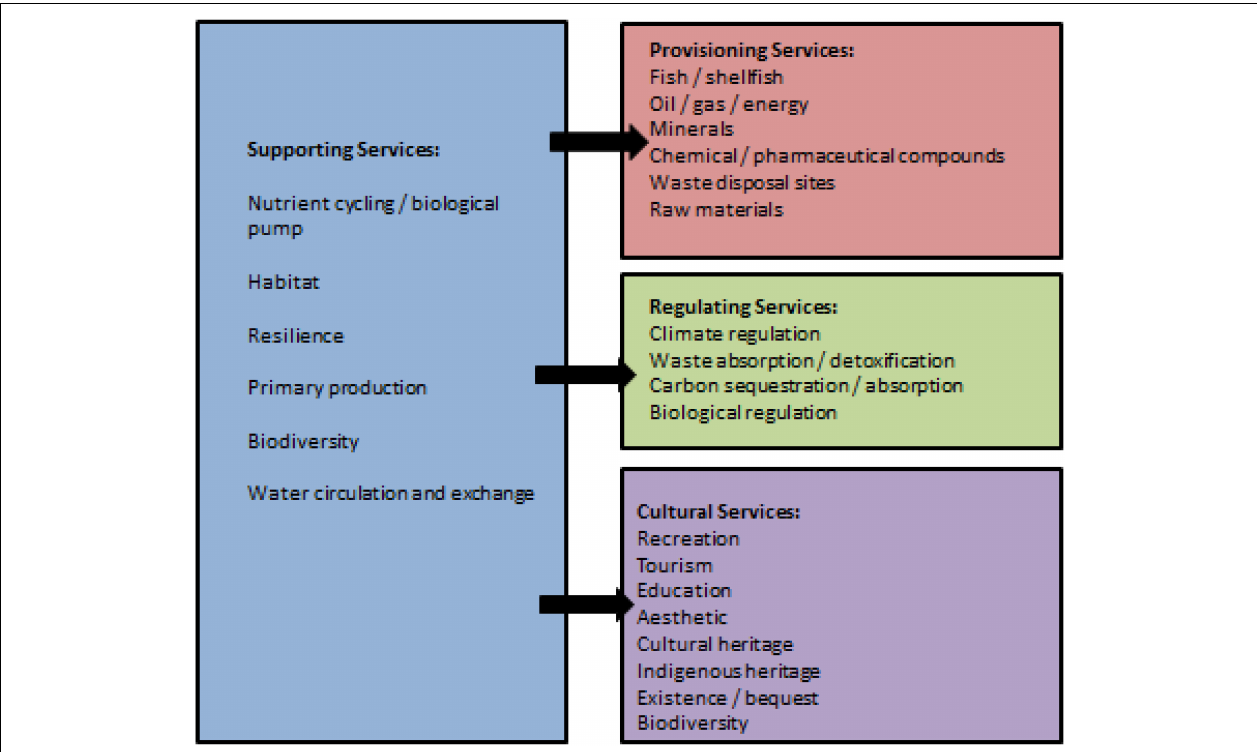
FIGURE 1 | Ecosystem services in the deep sea, using the Millennium Ecosystem Assessment framework.